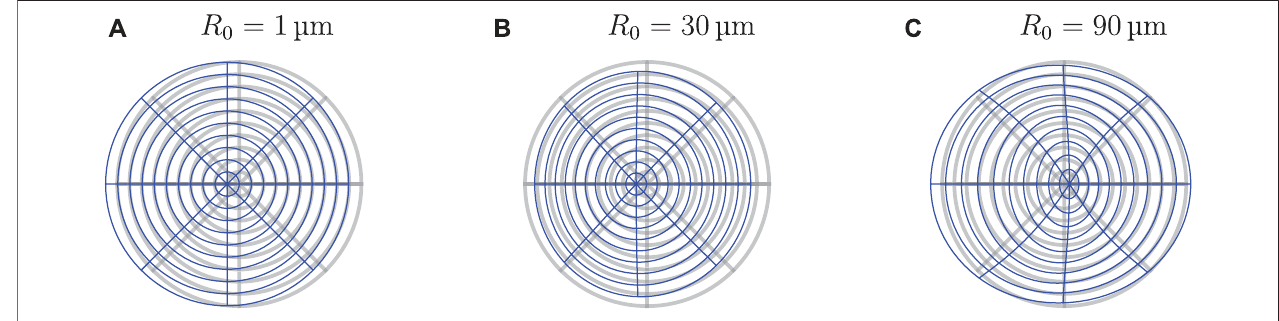
FIGURE4| ModesofoscillationofanHFEdropletofdifferentradii.Thedropletissuspendedinwaterandsubjectedtoastandingwaveat f =5 MHz.Dependingon the droplet size different mode participate in the oscillations: (A) dipole mode, (B) superposition of monopole and dipole mode, (C) complex superposition of multiple droplet